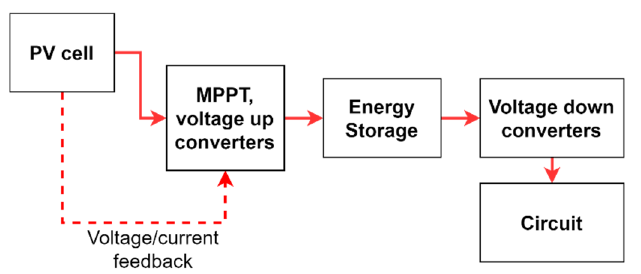
Figure 2. Harvest-Store-Use energy harvesting structure.